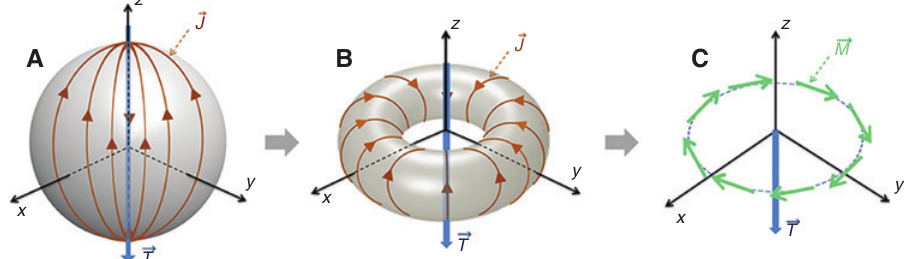
Figure 1: Current density and magnetic moment distributions associated with the toroidal moment. Poloidal currents excited at the surface of (A) a sphere and (B) a toroid. (C) Equivalently, a ring of magnetic moments is also attributed to the excitation of a toroidal